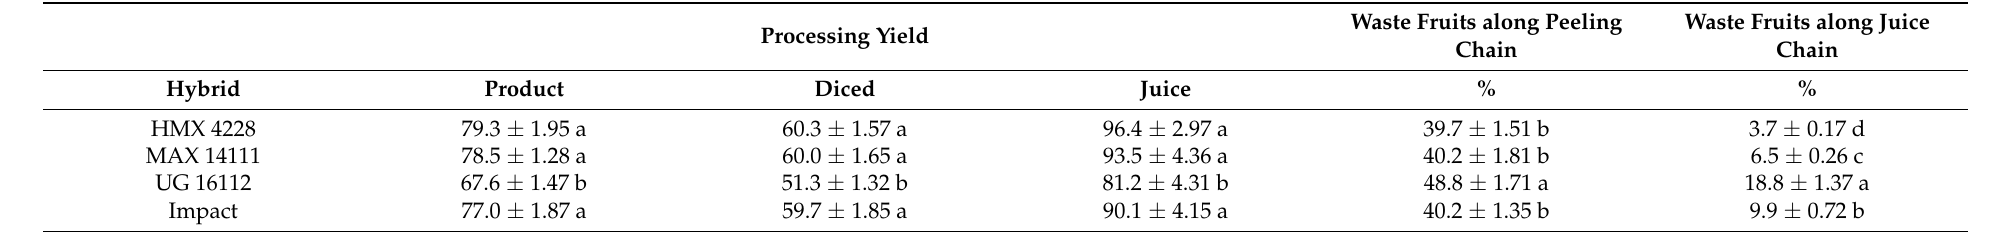
Table 2. Processing yield of four hybrids for diced tomato.